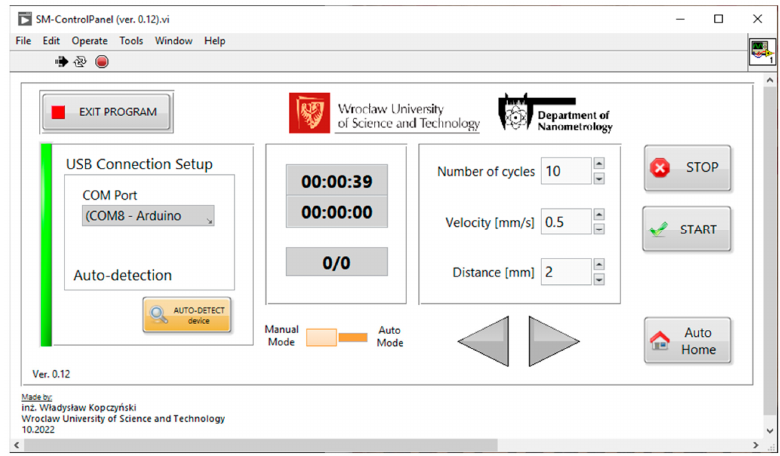
Figure 1. Wear machine: a—sliding table, b—indenter crane, c—indentation mass holder, d—indenter effector (zirconium ball), e—sample fluid cell, f—micrometer screw, g—clutch, h—stepper motor, and i—stepper motor driver.